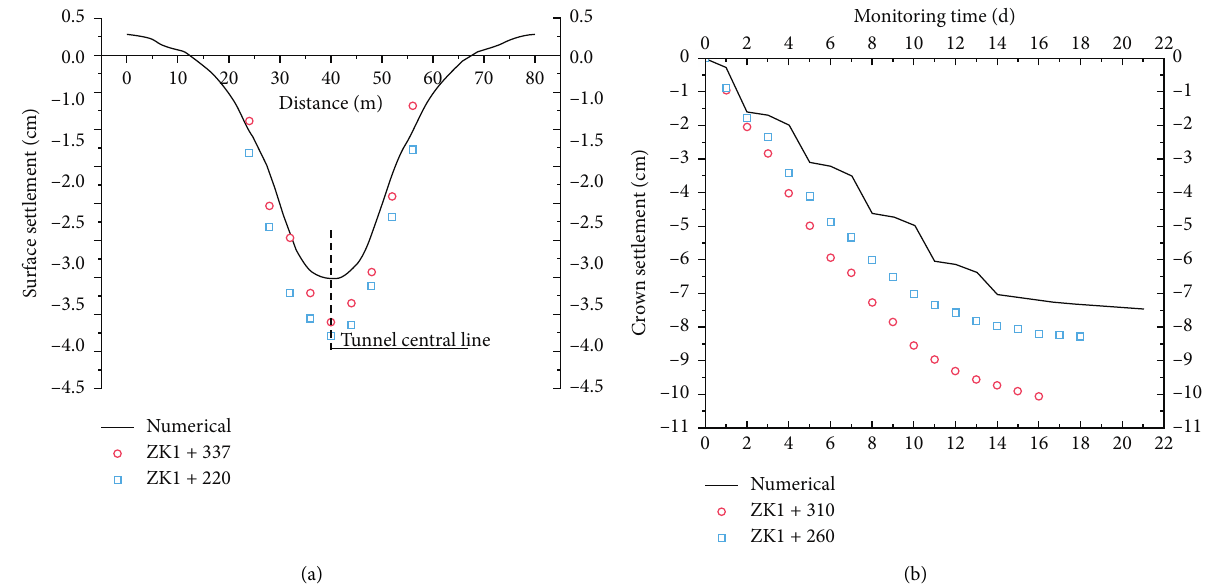
Figure 16: Comparison of numerical simulation and in situ monitoring results: (a) surface settlement; (b) crown settlement. Table 6: The Peck formula parameters of surface settlement troughs of urban shallow tunnels in silty soil in recent years in China. Tunnel